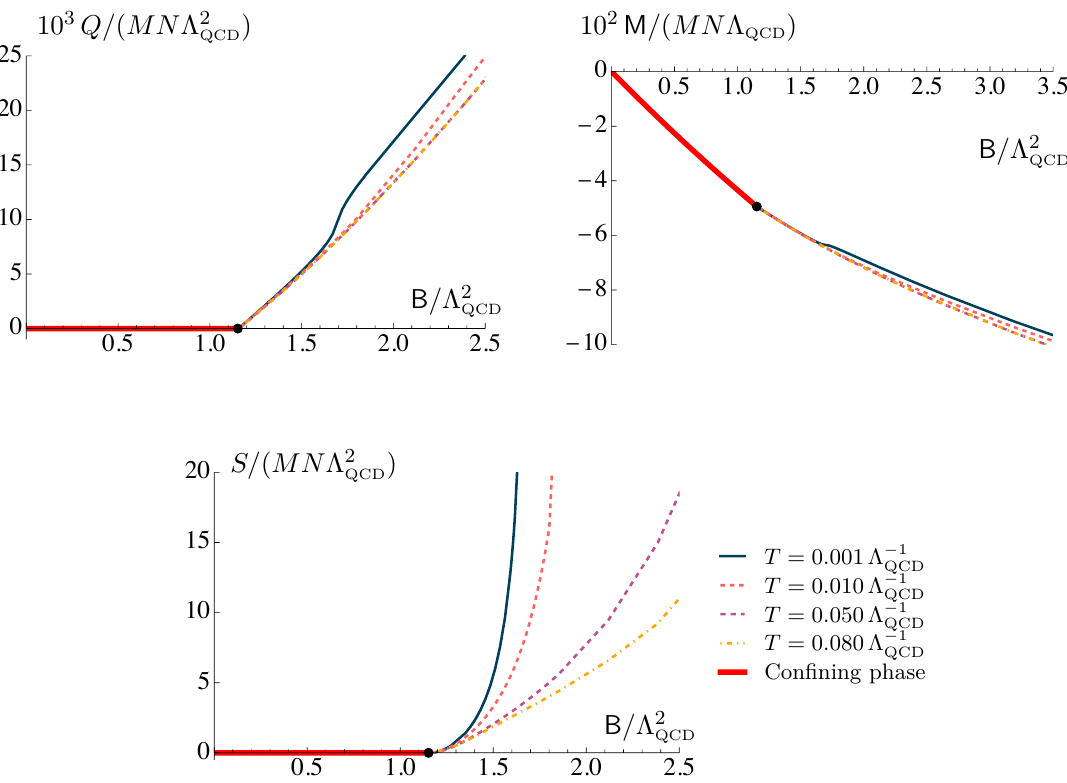
Figure 10. Charge density ( left ), magnetization ( right ) and entropy density ( bottom ) as a func- tion of the magnetic field in the vicinity of B (indicated by the black dot), for different choices triple of the temperature. In the confining phase, these quantities do not depend on the temperature, as indicated by the red, thick curves. The different curves, for any choice of the temperature, are continuous at B , indicating that the transition is second triple